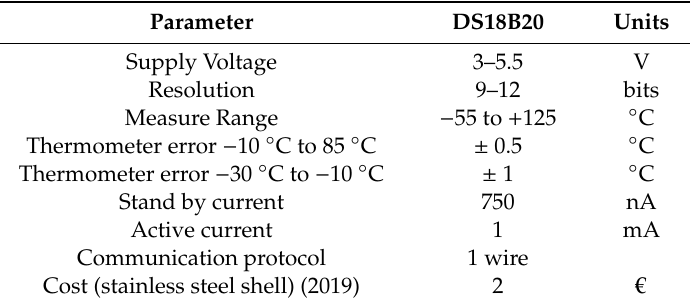
Table 5. DS18B20 sensor characteristics [62].